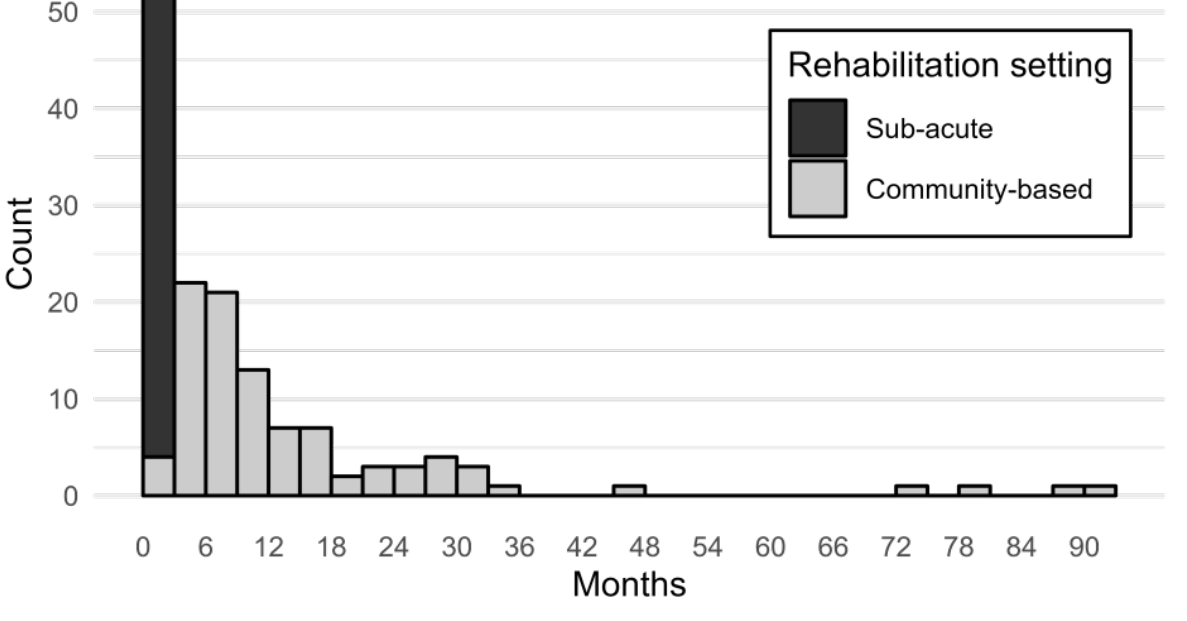
Figure 1. Time since injury at assessment. Note. The histogram shows frequency distributions of months since injury among participants in sub-acute ( n = 49) and community-based rehabilitation ( n = 100), respectively. Bins span 3 months. Two outliers at 153 and 161 months, respectively, are not shown. Table 1. Characteristics of participants.